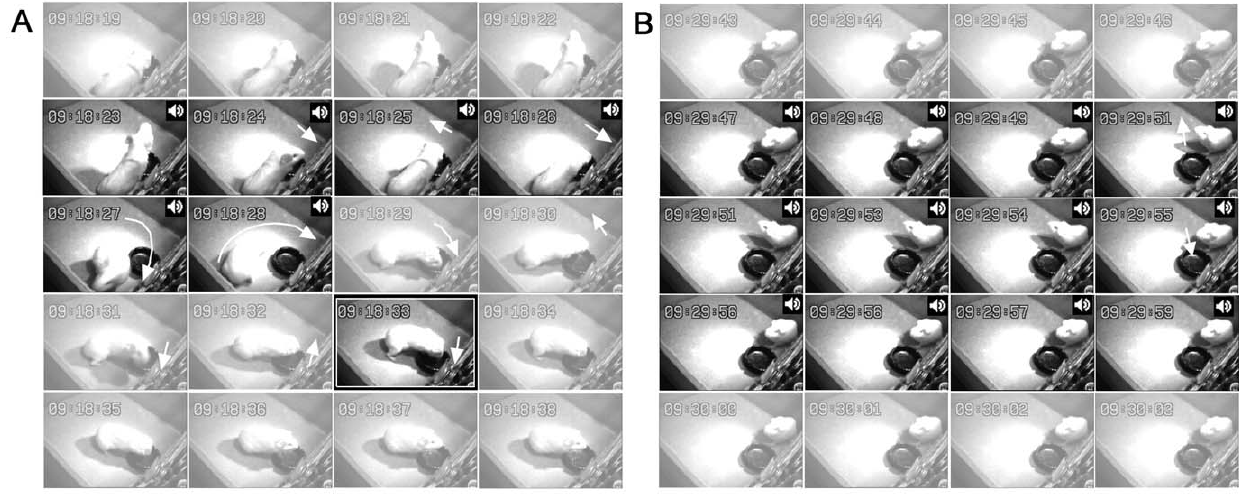
Figure 3. Sequences of video frames showing the typical behavioral responses to target and non-target sounds. Following the playback of the target footstep sound ( A ), a fully conditioned guinea pig displays circling locomotion and/or quick head swaying. Such reactions are not evoked by a non-target sound ( B ). Frames are taken approximately every 1 s. Sound-on periods are indicated by speaker symbols. Pellets are fed at the timing of the enclosed frame ( A ). Head motions are indicated by a set of white short arrows with the arrowhead pointing to the direction of movement. The track of the circling locomotion is depicted by a set of white curved arrows.